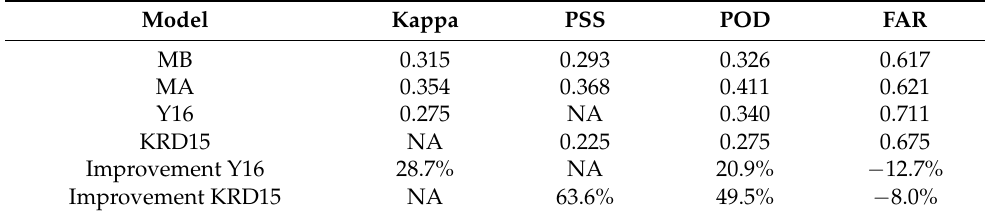
Improvement KRD15 NA 49.5% −